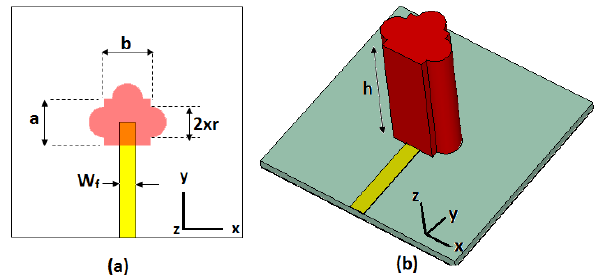
Figure 2: Geometry of the proposed NDRA, (a) top view, (b) 3D